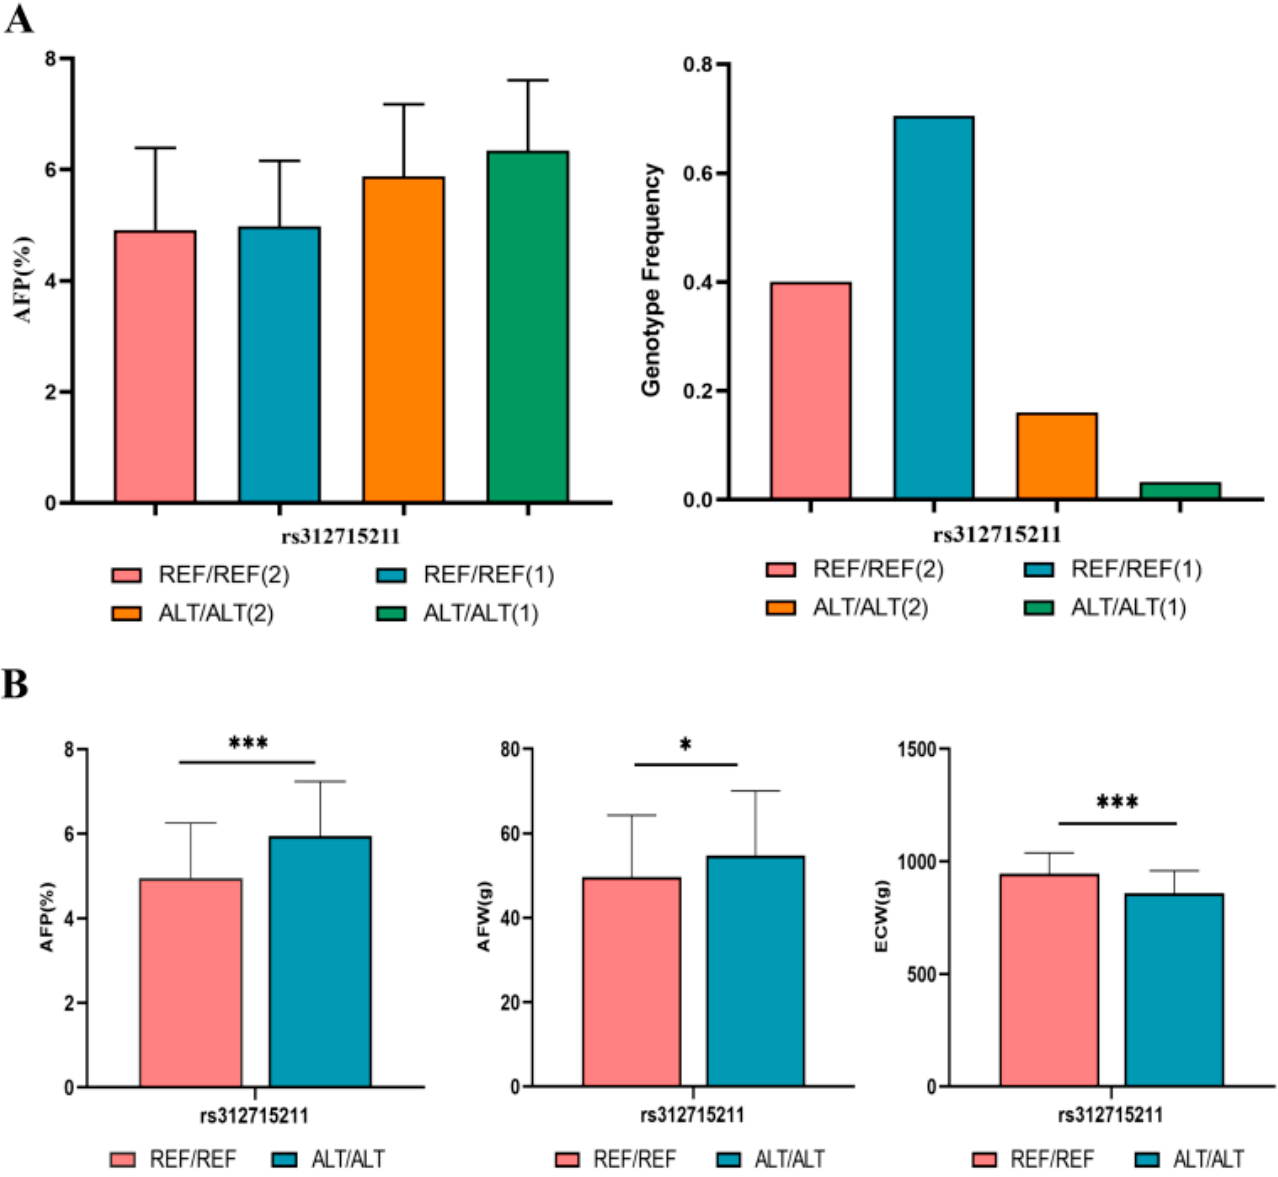
Figure 6. Genotype frequency and phenotype change of rs312715211 between the selected line and control line. ( A ) Phenotype and genotype frequency of candidate SNPs in the (1) selection line: 252, (2) control line: 268. ( B ) Candidate SNP phenotypes abdominal fat percentage (AFP), abdominal fat weight (AFW), and eviscerated carcass weight (ECW) in wild and mutant lines. AFP, AFW, and ECW were significantly increased after rs312715211 mutation, * p < 0.05, *** p < 0.001.